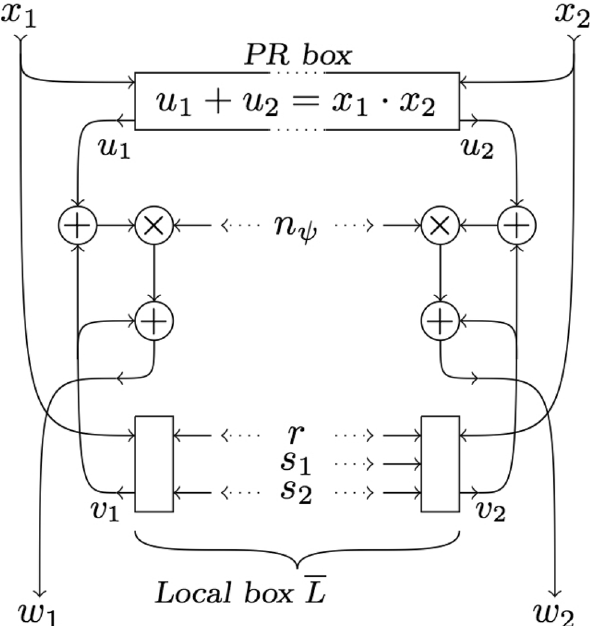
Figure 4. Stochastic process that reproduces, asymptotically, the mixture (14) for the maximally nonlocal quantum box Q ψ in Lemma 4.1. The random bit n ψ gets the value 1 with probability given by the strength of causal nonlocality = + − ψ ψ N W 1 1 Q